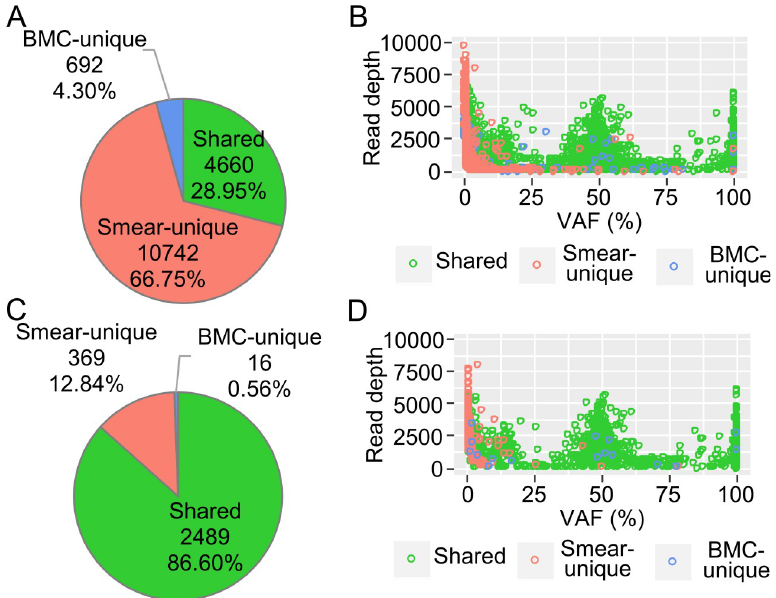
Fig 4. Characteristics of the variants detected using Mutect2 and the filtering effect. Combined results from five paired samples of smears and bone marrow cells (BMCs) are shown. (A) Pie chart of the smear-unique, BMC-unique, and shared variants. (B) Distribution of the detected variants. VAF, variant allele frequency. The smear-unique, BMC- unique, and shared variants are color-coded. (C) Pie chart of the variants after filtering with FilterMutectCalls. (D) Distribution of the filtered